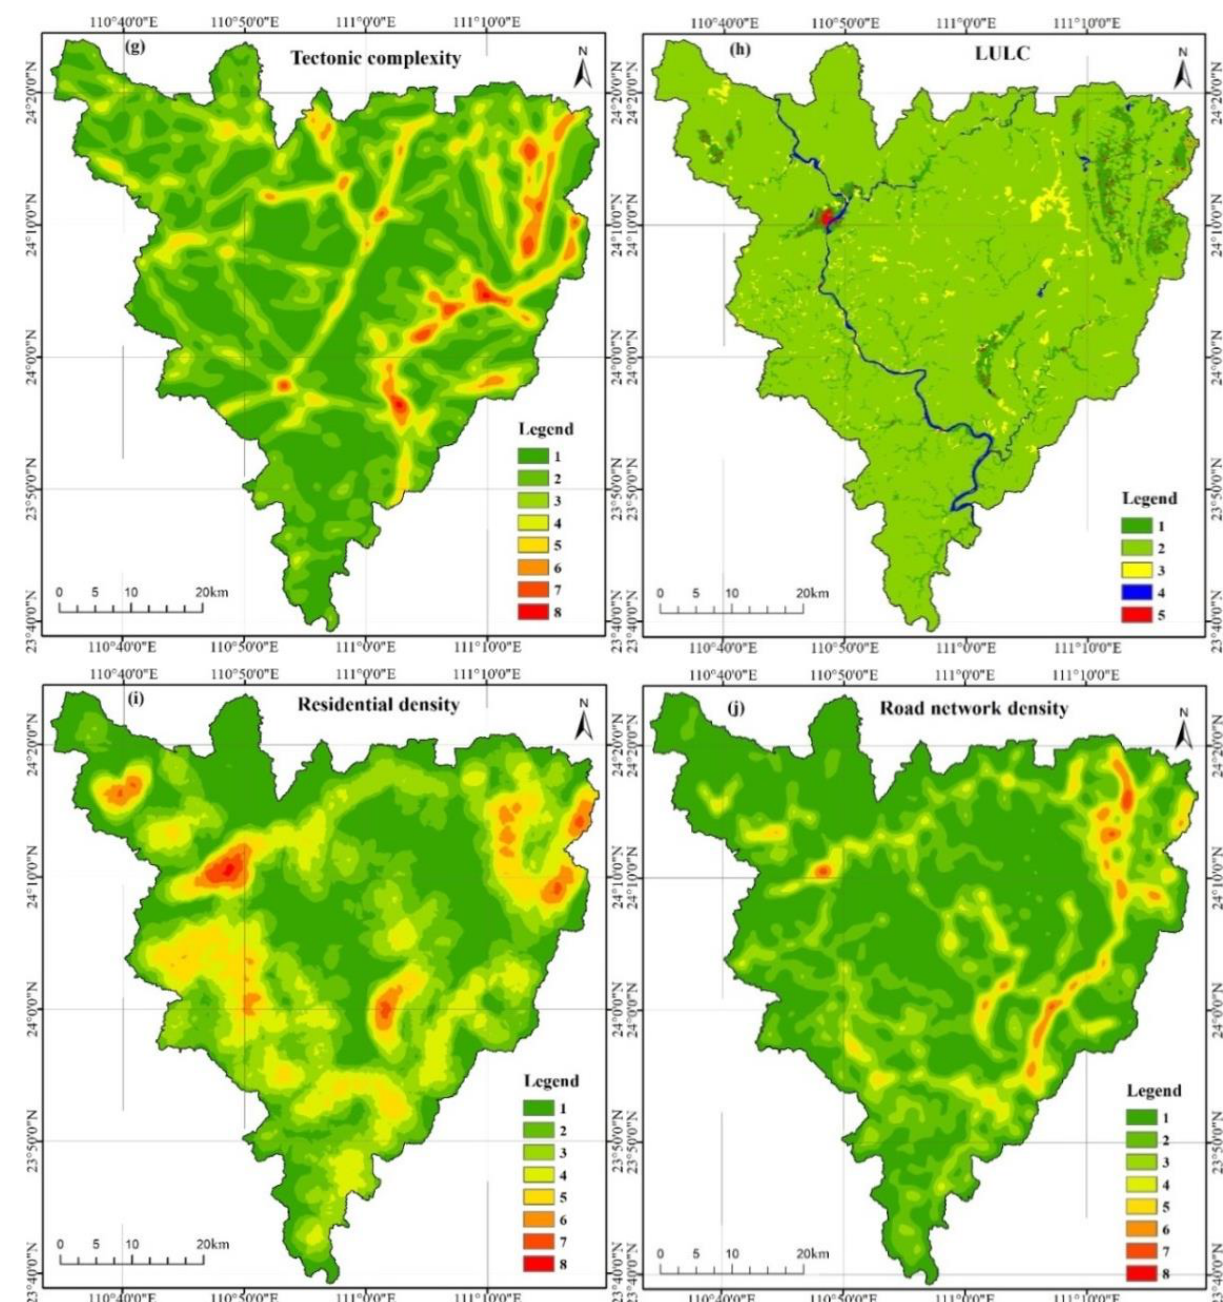
Figure 2. Attribute value of landslide evaluation factors. ( a ) slope, ( b ) aspect, ( c ) plan curvature, ( d ) annual rainfall, ( e ) NDVI, ( f ) stratum lithology, ( g ) tectonic complexity, ( h ) LULC, ( i ) residential density, ( j ) road network density.